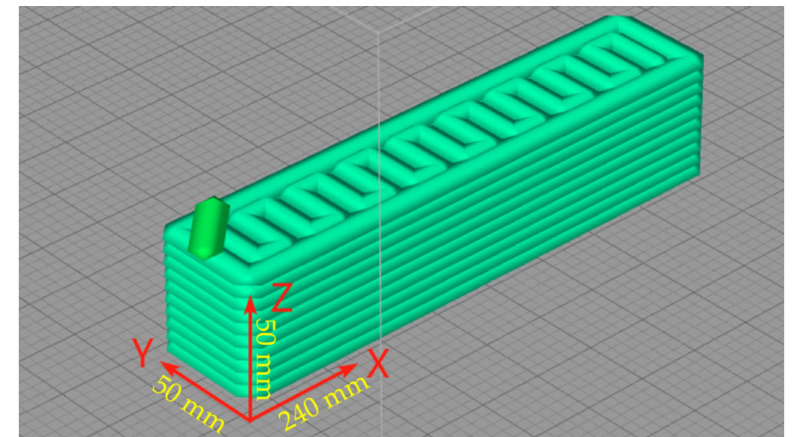
Figure 5. Illustration of the 3D printed beams for flexural strength